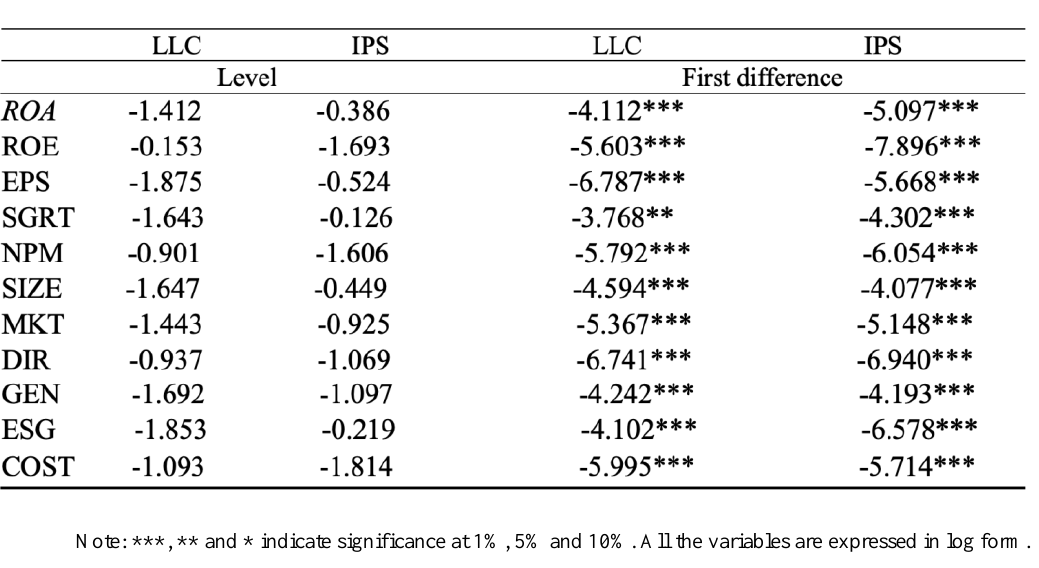
Table 2: Panel unit root tests